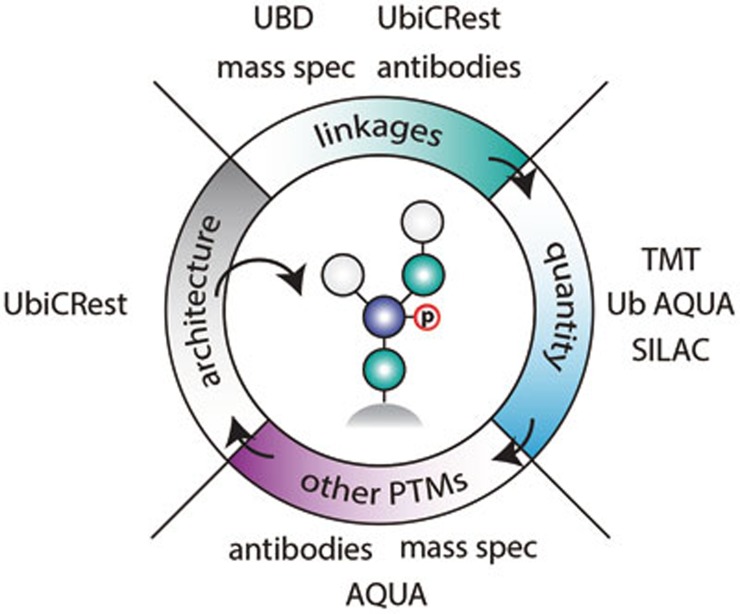
Studying Ub modifications. Linkage-specific UBDs47,48, Ubiquitin Chain Restriction (UbiCRest) analysis46, linkage-specific antibodies49,50,51, a Ser65-phosphoUb antibody42 and mass spectrometry52 allow for the identification of chain types and ubiquitin modifications. Mass spectrometry enables the quantitation of all ubiquitin linkages in a sample. Relative quantitative techniques include tandem mass tag (TMT) labeling and stable isotope labeling by amino acids in cell culture (SILAC), while absolute quantification (AQUA) strategy determines the exact quantities of each ubiquitin chain type52. Similar strategies are available to identify and quantify small molecule and Ubl modifications of ubiquitin.